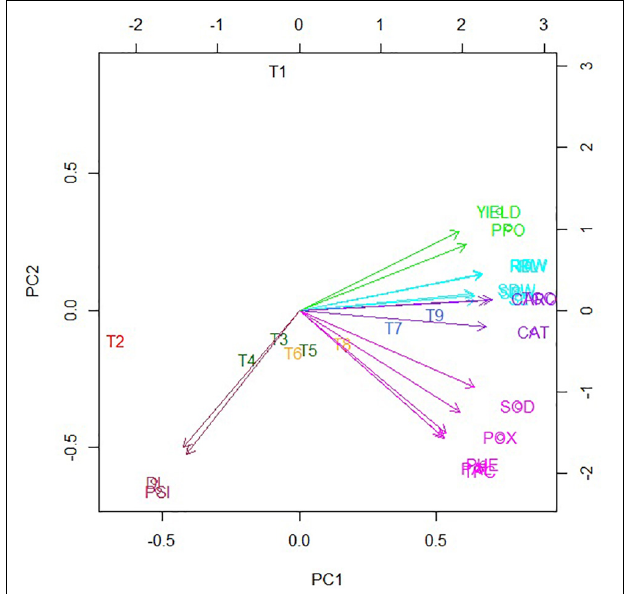
FIGURE 6 | Biplot of the first two principal coordinates for nine treatments and collective data of disease, growth, physio-chemical, and yield attributes. The color scheme is kept the same as for respective dendrograms. DI, disease incidence; PSI, percent severity index; TCC, total chlorophyll content; CARO, carotenoids; TPC, total protein contact; PHE, total phenol content; SOD, superoxide dismutase; CAT, catalase; POX, peroxidase; PPO, polyphenol oxidase; PAL, phenylalanine ammonia-lyase; SL, shoot length; SFW, shoot fresh weight; SDW, shoot dry weight; RL, root length; RFW, root fresh weight; RDW, root dry weight. BS-01, Bacillus subtilis ; AS, Alternaria solani ; NPK, nitrogen, phosphorus, and potassium; Zn, Zinc. T 1 , − ve control (without inoculation of AS); T 2 , +ve control (with AS inoculation); T 3 , BS-01 + AS; T 4 , Zn (2X) + AS; T 5 , BS-01 + Zn (2X) + AS; T 6 , NPK + AS; T 7 , BS-01 + NPK + AS; T 8 , Zn (2X) + NPK; and T 9 , BS-01 + Zn (2X) + NPK + AS.